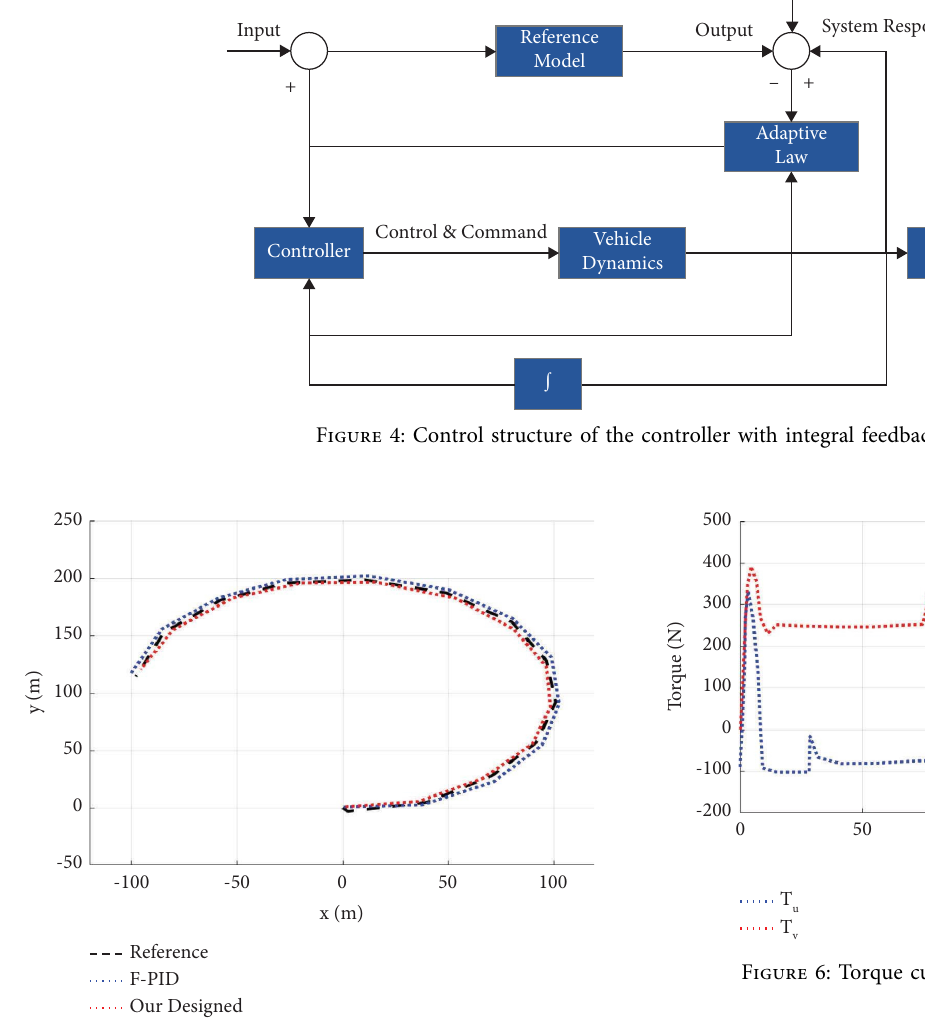
Figure 5: Trajectory tracking of USV.